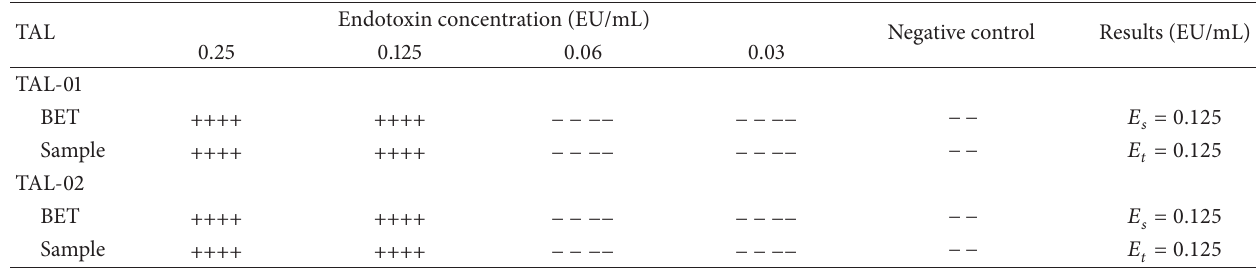
Table 2: Results of interference test of the ultrapure paraffin oil aqueous phase extract.